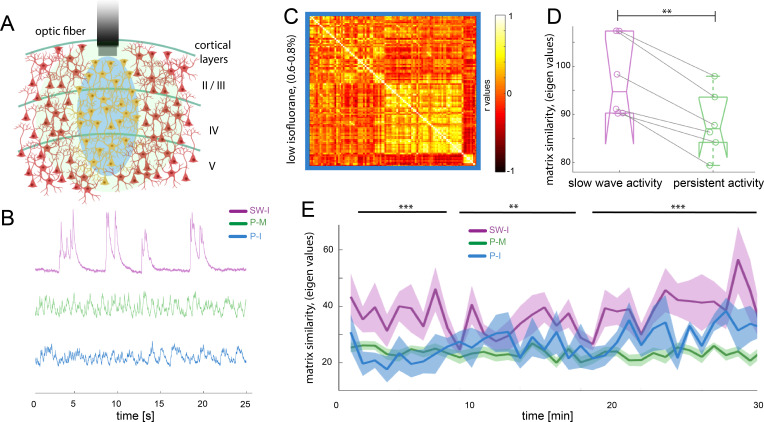
Different activity states of the brain result in characteristic functional connectivity matrices.(A) Calcium fiber photometry schematic. OGB-1 was bolus-injected and an optic fiber with a diameter of 200 µm was implanted at a cortical depth of about 300 μm. Blue light was used for excitation of OGB-1. Emitted fluorescence, comprising the changes in cytosolic calcium concentration of the local neural population was collected by the same fiber, and recorded by the fiber optometer. (B) Characteristic signal traces of photometry recordings during slow wave activity induced by high isoflurane (SW-I, magenta), and persistent activity induced either by medetomidine (P-M, green) or by lower concentrations of isoflurane (blue, P–I). (C) Average of the correlation matrices (n = 6) of the mean BOLD signal in 96 cortical regions under low isoflurane concentration. (D) Matrix similarity analysis of the low isoflurane (P-I n = 6) persistent activity experiments compared with the average matrix generated under high isoflurane related slow wave activity (SW-activity, magenta) and the medetomidine-induced persistent activity (P-M, green), **p<0.01, (n = 6, paired t-test). (E) Matrix similarity observed under the three conditions under a dynamic connectivity analysis. Lines represent the average of individual variability for slow wave activity (SW-I, n = 15, magenta), persistent activity induced with medetomidine (P-M, n = 15, green) and persistent activity induced with isoflurane (P-I, n = 6 blue), the semitransparent stripe correspond to the standard error of the mean for each condition. The matrices were generated for a 5-min period with steps of 1 min and were compared with the average matrix generated in the first 5 min for each individual animal, **p<0.01 (paired t-test n = 15 in SW-I and P-M conditions).